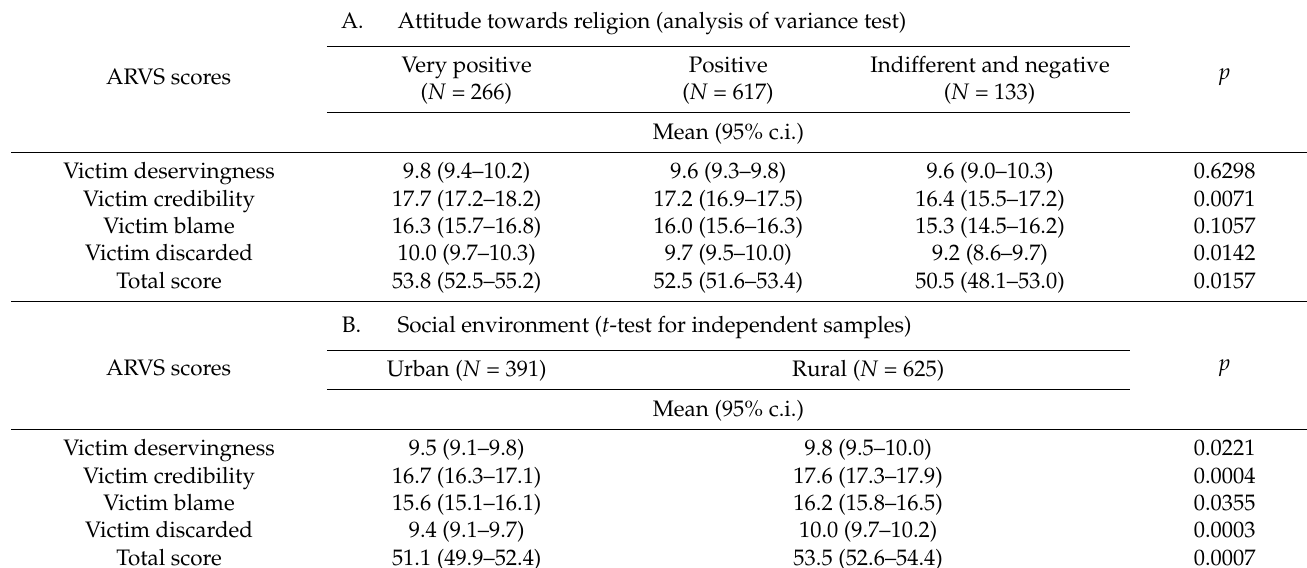
Table 3. ARVS scores among the surveyed